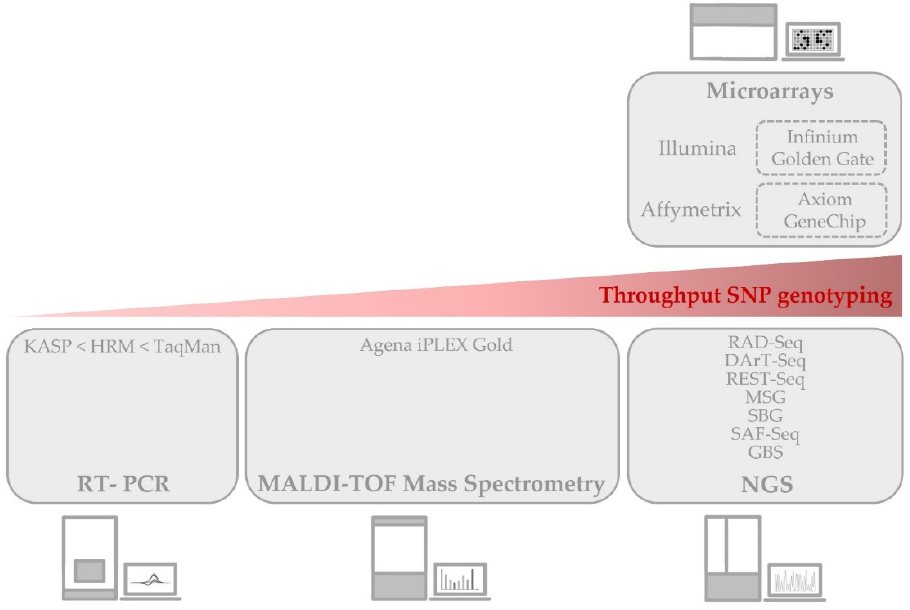
Figure 1. Comparison of the SNP genotyping techniques most commonly used in crops grouped by the platforms in the throughput level.